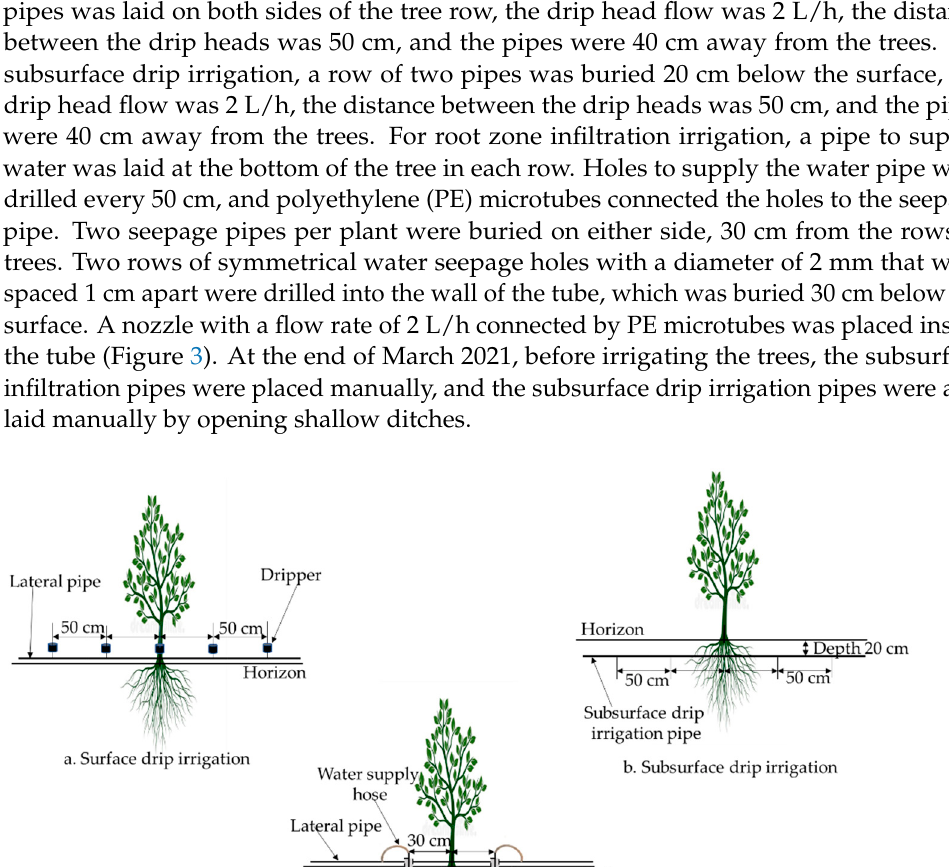
Figure 2. The Korla fragrant pear planting model. surface drip (F1), subsurface drip (F2), and root zone infiltration (F3); 70% ETC (W1), 85% ETC (W2), and 100% ETC (W3); Flood irrigation at 100% ETC served as the check (CK) or control.